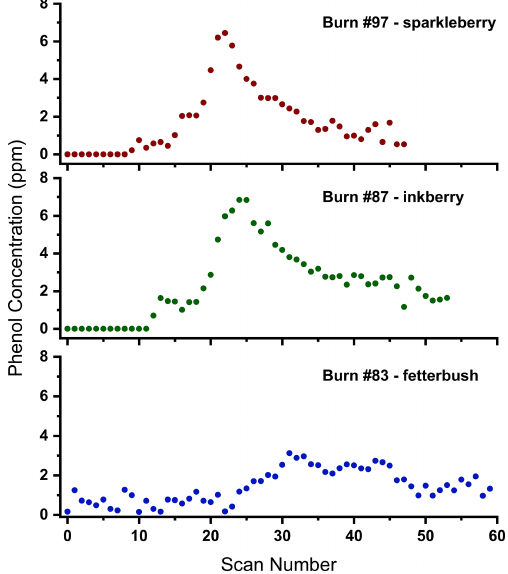
Figure 7. Temporal mixing ratios of phenol for different shrub species. Phenol mixing ratios plotted over time are indicated by the scan number for Burn 97 with sparkleberry (red), Burn 87 with inkberry (green), and Burn 20 with fetterbush (blue), all on a lon- gleaf pine straw